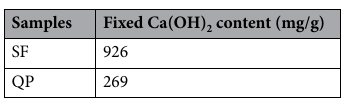
Table 3. Modified Chapelle Pozzolanic activity